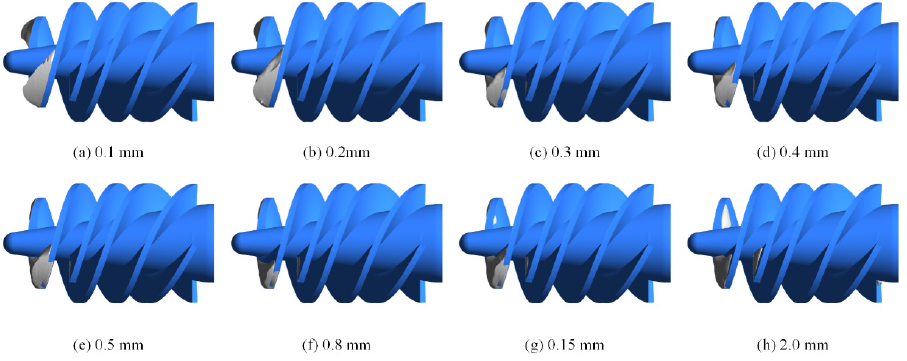
Figure 11. ISO surface distribution of volume fraction of 0.1 under each TC.